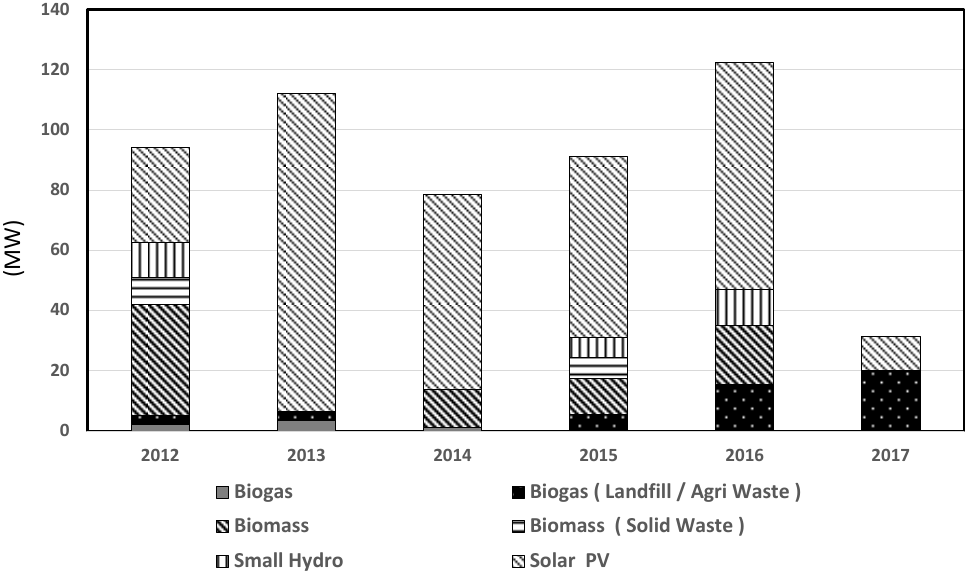
Figure 18. Installed Capacity (MW) of Commissioned RE Installations (FiT Program) [90].